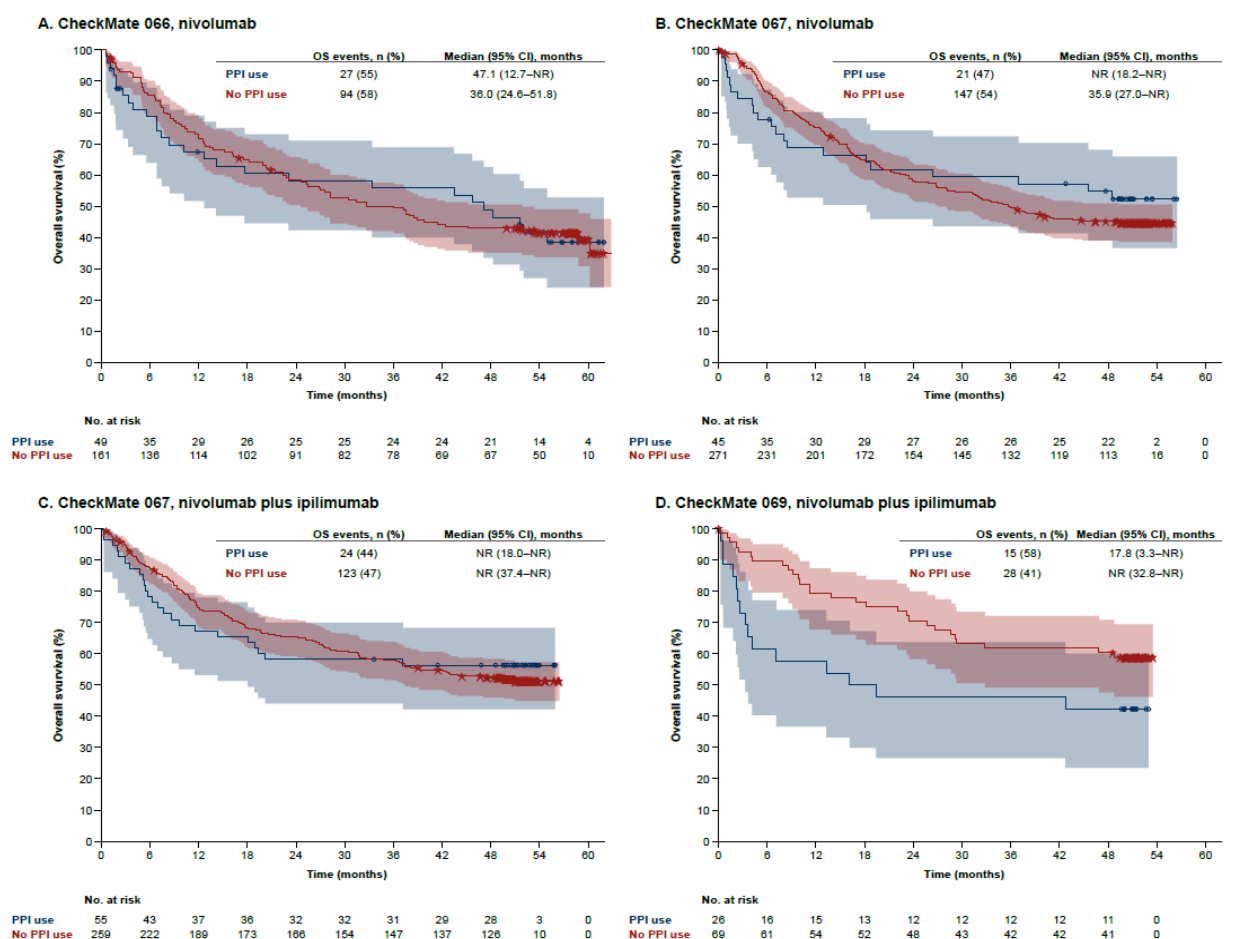
Figure 3. Overall survival by baseline PPI use in the nivolumab-containing treatment arms of CheckMate 066, 067, and 069. Kaplan–Meier estimates of overall survival are shown in the nivolumab arms of CheckMate 066 ( A ) and CheckMate 067 ( B ) and in the nivolumab plus ipilimumab arms of CheckMate 067 ( C ) and CheckMate 069 ( D ). Shaded areas are 95% log–log confidence bands. CI: confidence interval; OS: overall survival; PPI: proton pump inhibitor.